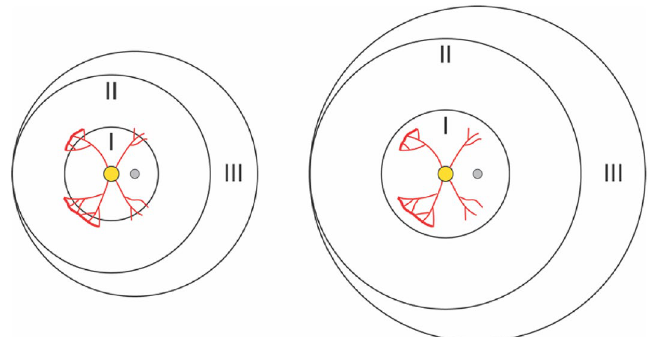
Figure 5. Neonatal eye size may affect zone designations. Schematic illustrating the hypothesis that the same absolute area of ROP involvement could be designated as Zone II in one eye but as Zone I in a larger eye. Zones are indicated by Roman numerals, optic disc in yellow, and macula in